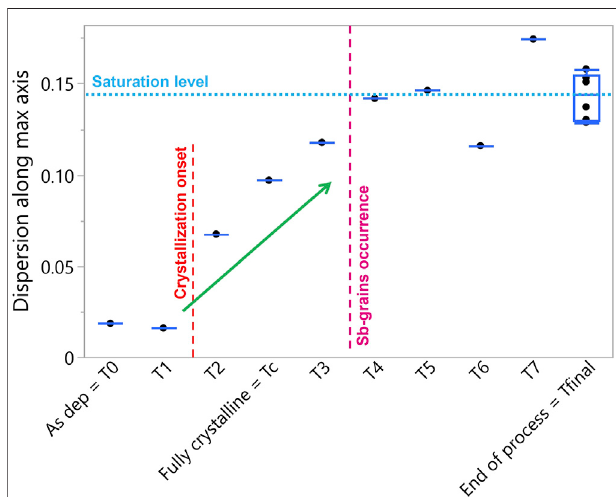
FIGURE 5 | Dispersion along the maximum axis of 90% con fi dence ellipse in function of BEOL steps: red and magenta vertical dotted lines indicate characteristic points of process evolution, “ crystallization onset ” and “ Sb-grains occurrence ” ; cyan horizontal dotted line indicates saturation level for the dispersion along the maximum axis value after the Sb-rich grains occurrence; green arrow highlights the linear trend of dispersion along the maximum axis with process steps.